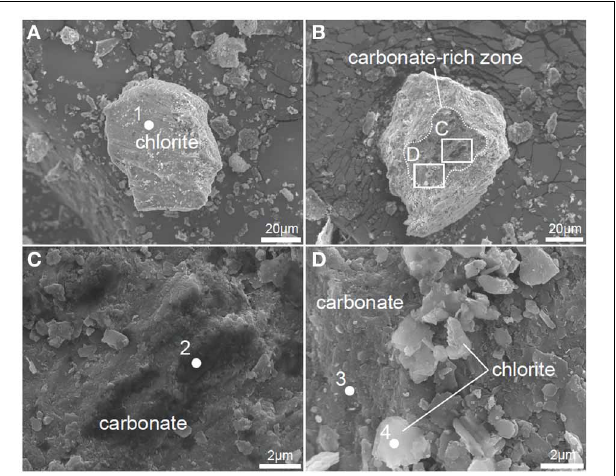
FIGURE 4 | FE-SEM images of powdered pre-sand and post-sand. (A) Chlorite in pre-sand. (B) Carbonated chlorite aggregate in post-sand. (C) Magnified view of inset in (B) to show carbonate and chlorite aggregate in post-sand, respectively. (D) Magnified view of inset in (B) to show chlorite grains and the carbonated part of the chlorite aggregate.